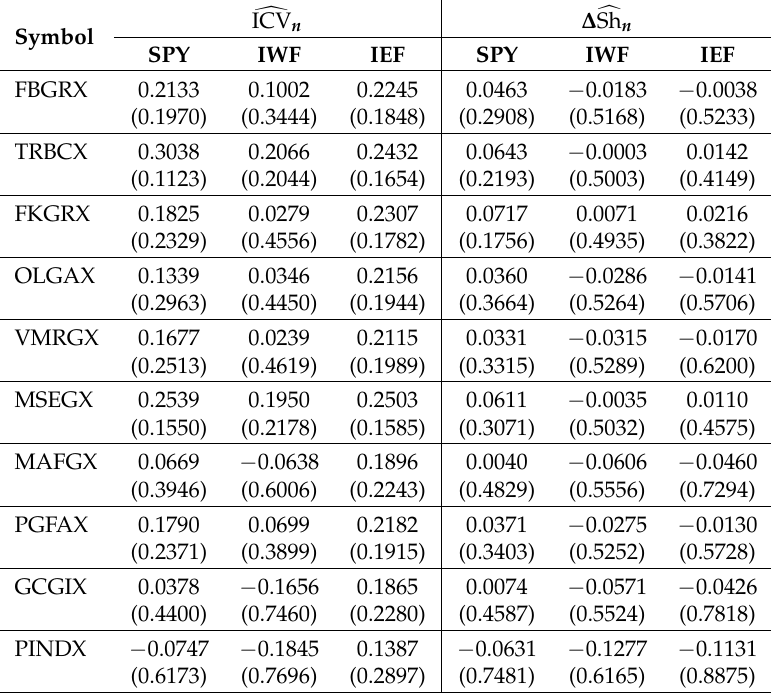
ICV n and ∆ Sh n together with their corresponding p -values (in parentheses) for (cid:99) (cid:100)